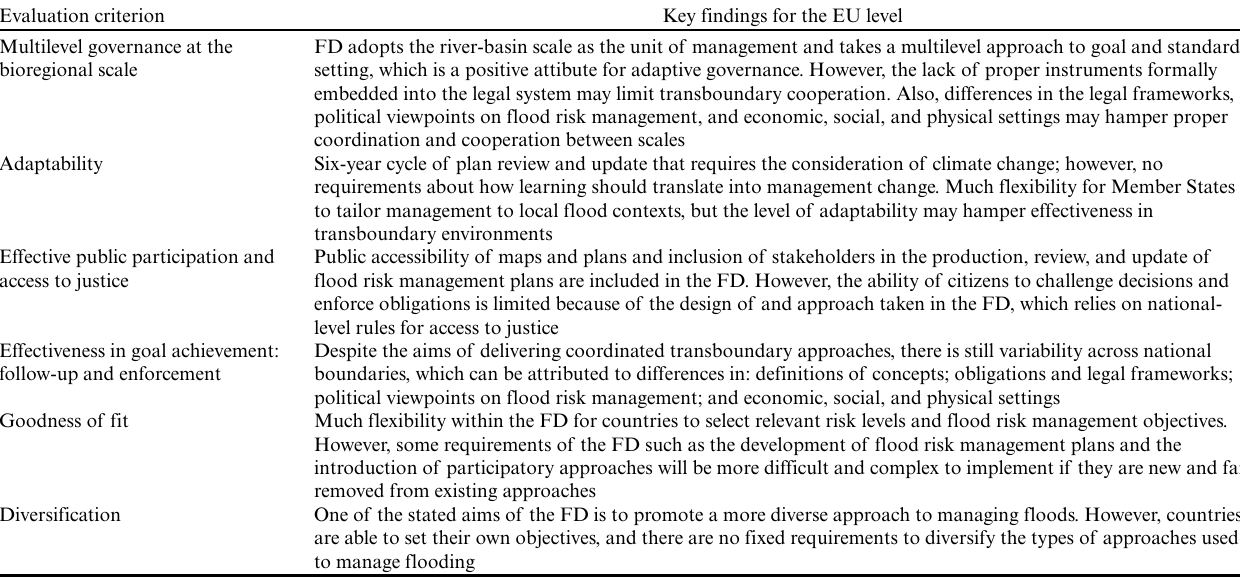
Key findings for the EU